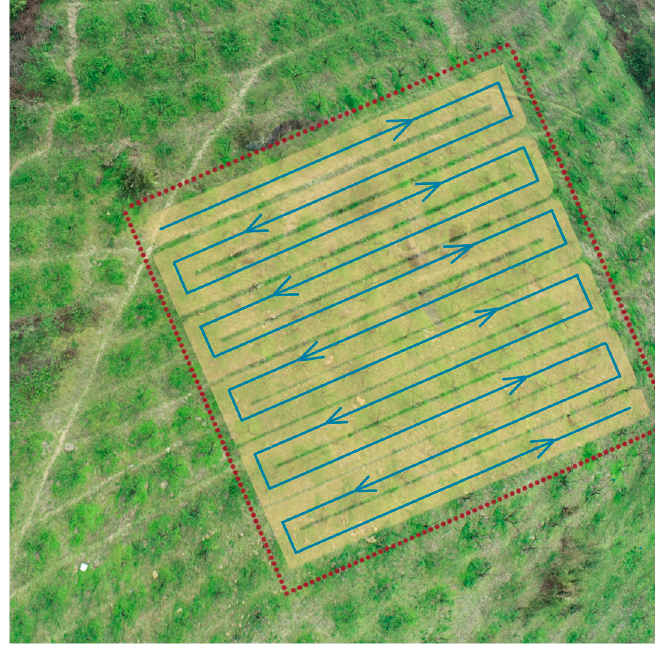
Figure 4. Boustrophedon Cellular Decomposition.